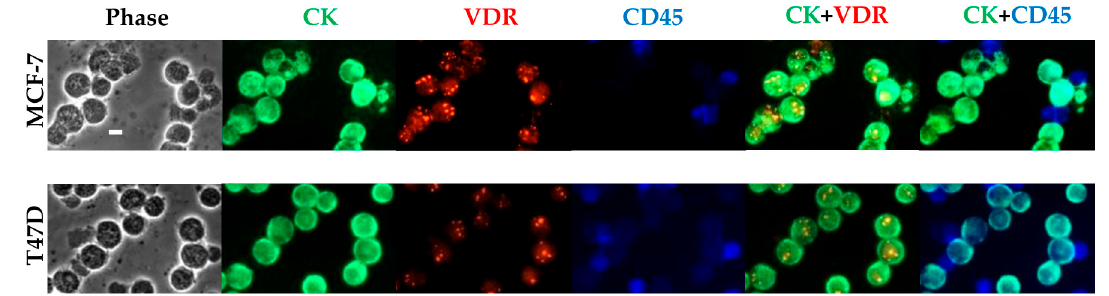
Figure 1. VDR expression detection in MCF-7 and T47D cells mixed with PBMCs. Fluorescence labeling of VDR (in red), CK (in green), and CD45 (in blue) was performed on a 10 6 MCF-7 and T47D cells/PBMCs mix (3/1). Original magnification, ×40. Scale bar (white bar in the upper left image), 10 μ m. CK: cytokeratin; VDR: vitamin D receptor; PBMCs: peripheral blood mononuclear cells.